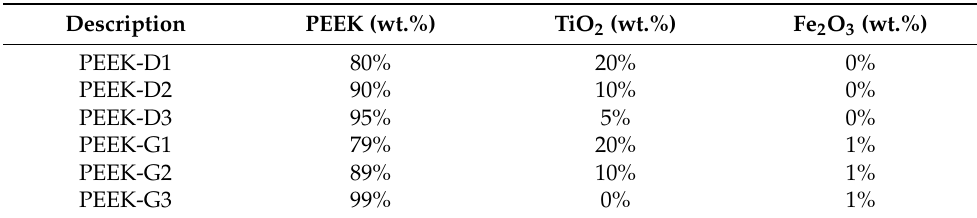
Table 1. The mix proportions of PEEK